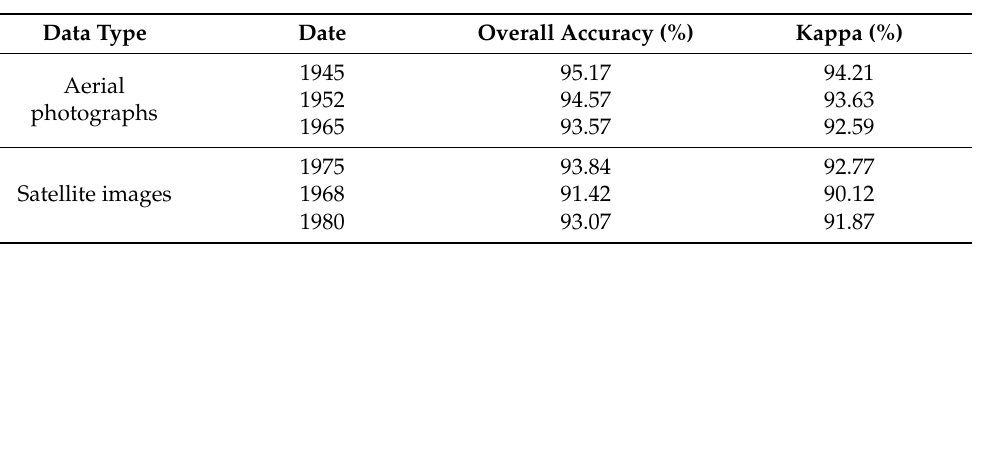
Figure 16. The 1952 Ruen aerial photograph ( a ) assigning the tree cover class to objects based on the 1965 Ruen land cover map ( b ) tree cover class objects after edition.